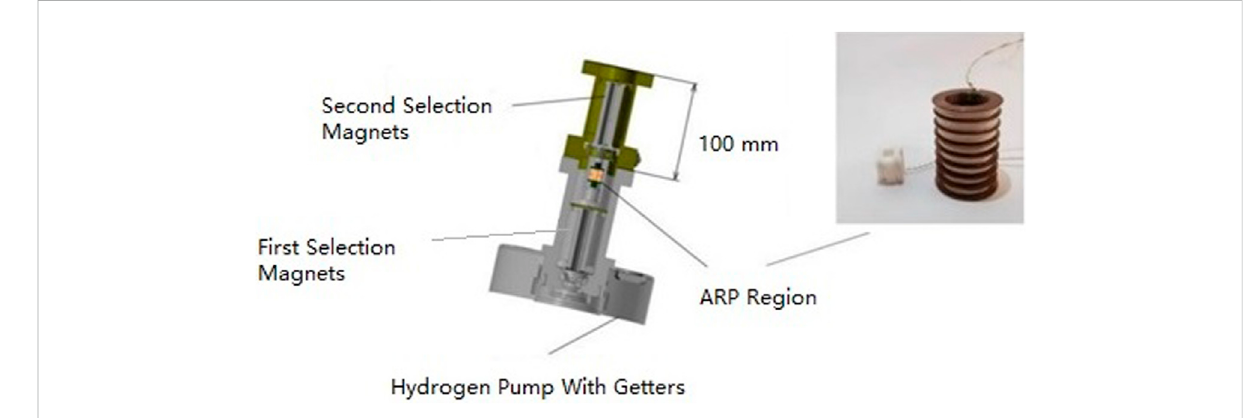
FIGURE 8 Single-state ( F = 1, m F = 0) selector using the adiabatic rapid passage (ARP)